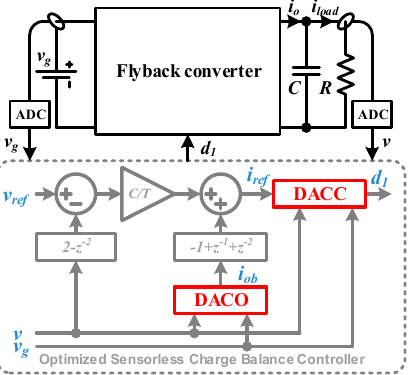
Figure 5. Flyback converter with optimized sensorless charge balance controller.